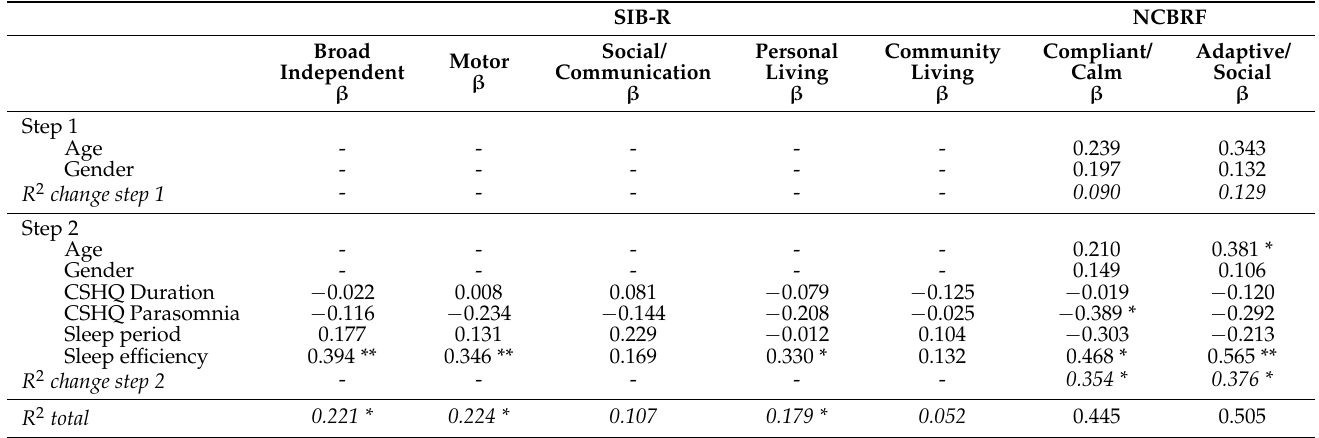
Table 3. Predicting child functioning from child